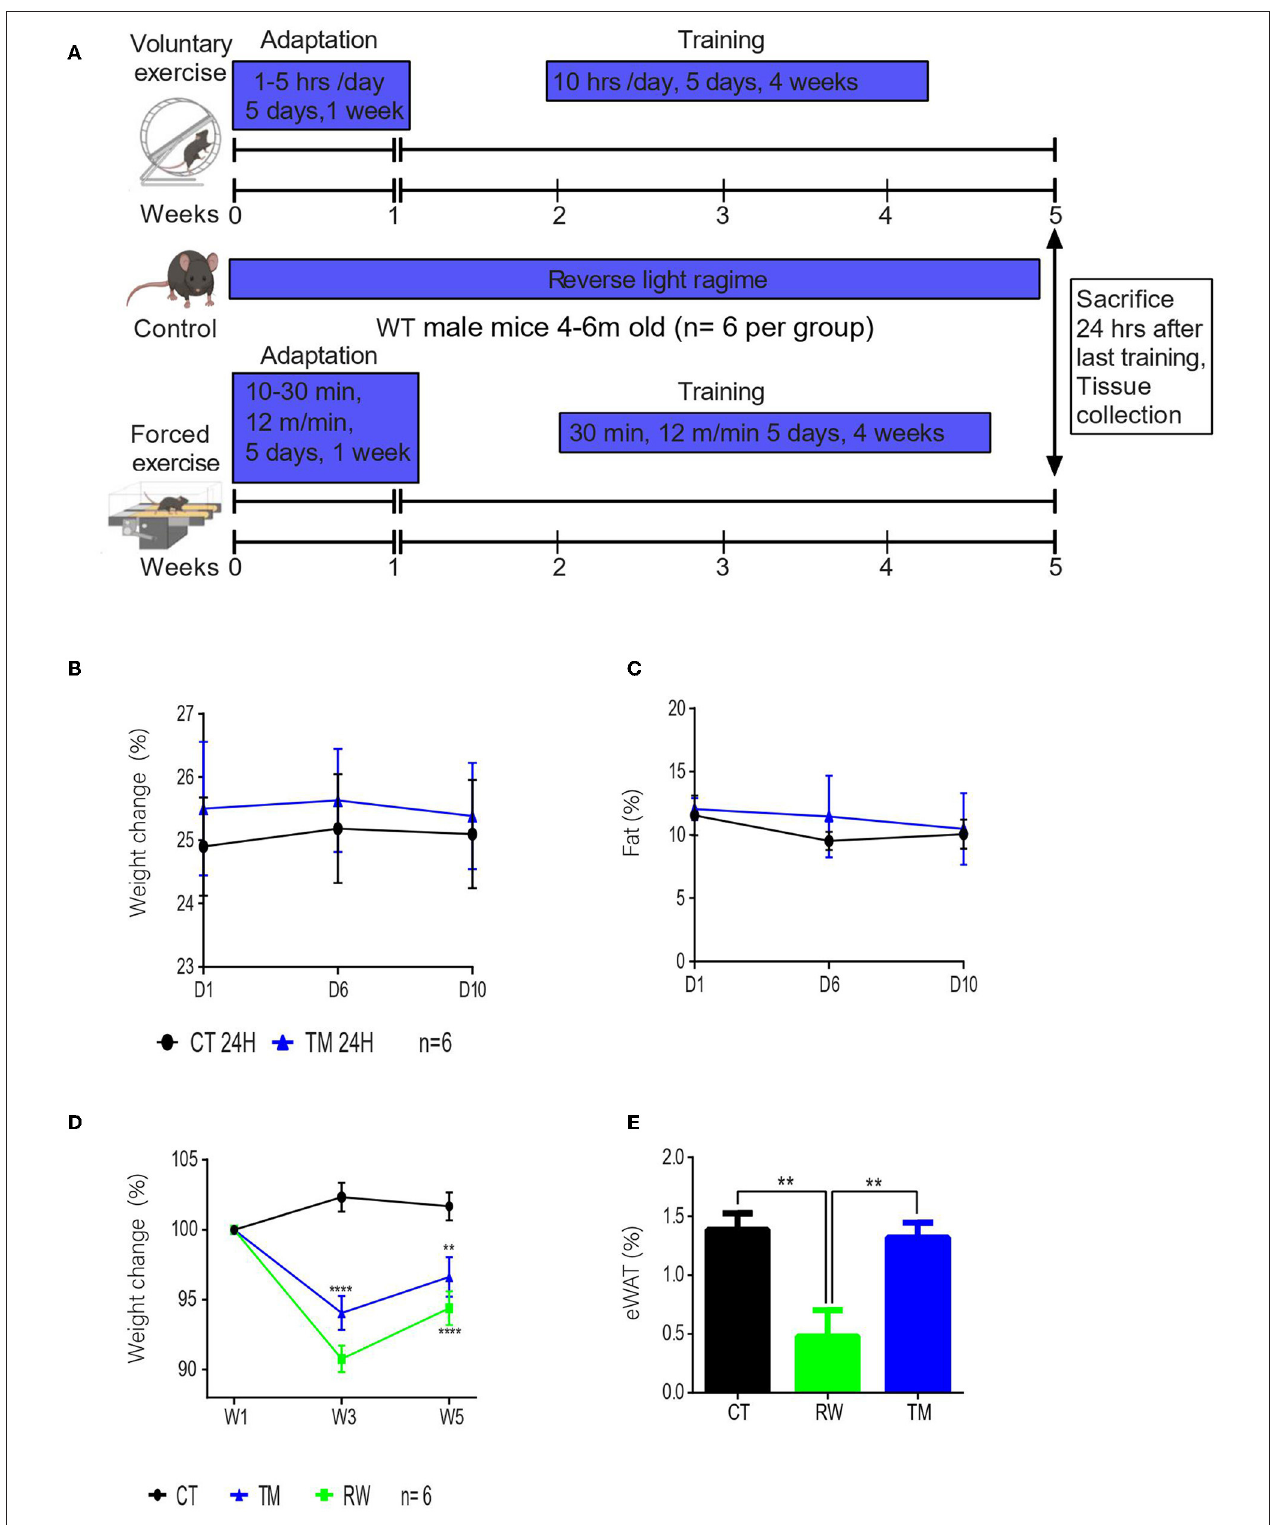
FIGURE 1 | Voluntary physical exercise has a greater effect on body composition. (A) Schematic figure of experimental design. Drawn by Biorender. (B) Percentage change in body weight measurements before exercise (D1), on exercise day 6 (D6), and at the end of the training session, day 10 (D10). (C) Percentage average body fat of young (3 months) WT male mice from each group (control and treadmill). (D) Percentage change in body weight measurements, before exercise (start), after